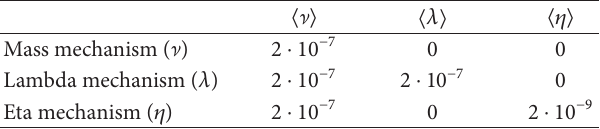
Table 4: The neutrino parameter values chosen for 0 ] 𝛽𝛽 mecha- nisms described in the text.